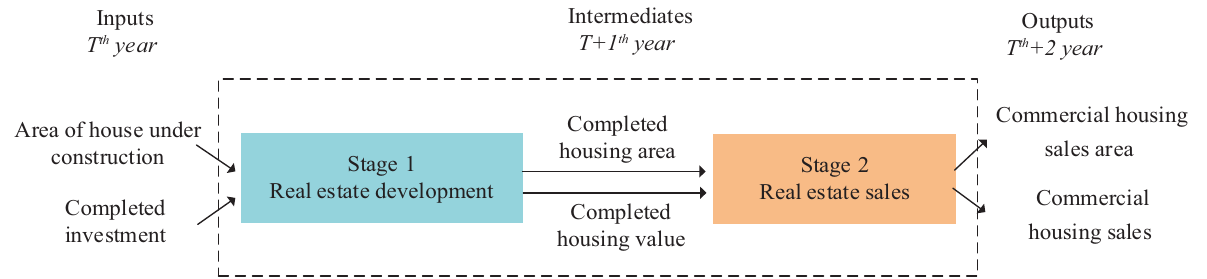
Figure 2. The two-stage logical model of the real estate production